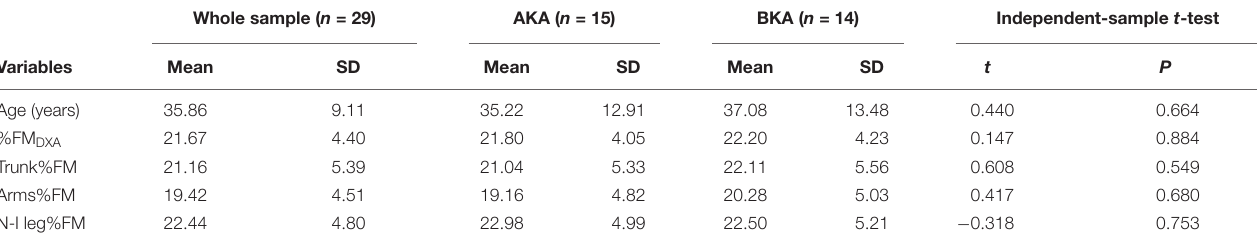
TABLE 2 | Participant’s age and DXA-measured whole-body and regional percentage of fat mass.